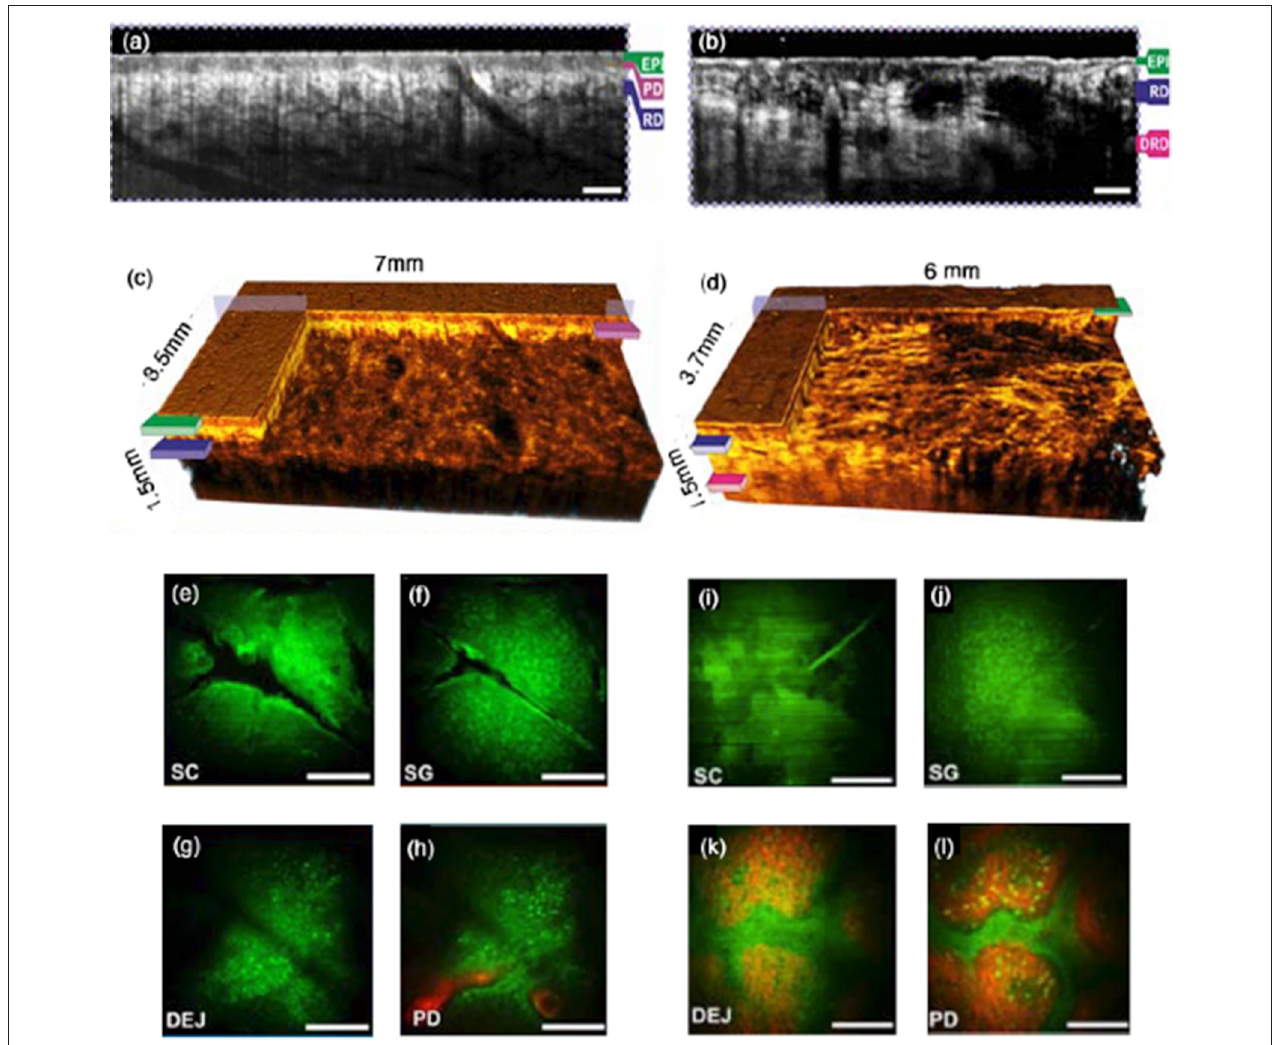
FIGURE 6 | In vivo clinical MPM/OCT in healthy versus basal cell carcinoma (BCC) in the dorsal forearm. (a,b) OCT tomograms of healthy skin and of BCC. The scale bars indicate 500 µ m; (c,d) 3D rendered OCT volume of healthy skin BCC. (e–h) MPM of healthy skin at different depths. ( i–l ) MPM of BCC at different depths. The scale bars indicate 100 µ m. MPM is centered at the OCT volume. Green corresponds to TPF with contributions from melanin, NADH, and elastin, red displays the SHG signal attributed to collagen; EPI- epidermis; SC, stratum corneum; SG, stratum granulosum; SS, stratum spinosum; DEJ, dermalepidermal junction; RD, reticular dermis; PD, papillary dermis. Modified from Alex et al. [175] with permission from John